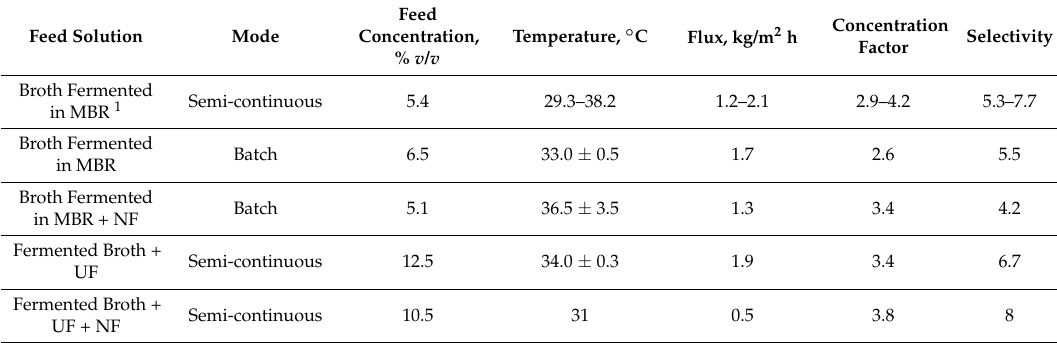
Table 3. Performance data for the recovery of ethanol from fermented broth solutions.